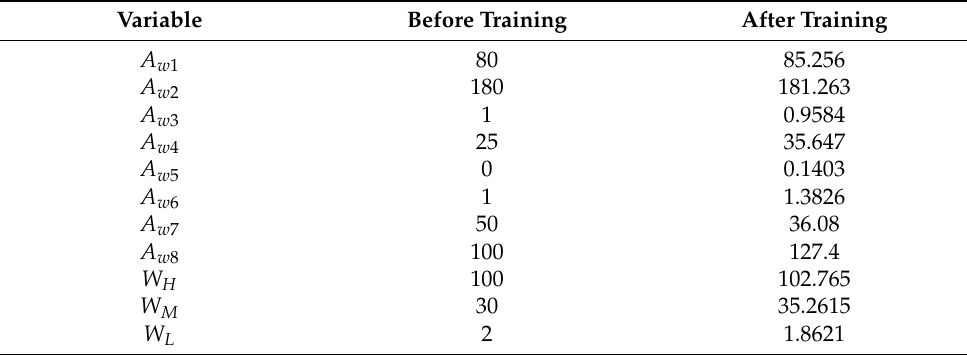
Table 8. The relationship between the fuzzy sets and situations. Variable Before